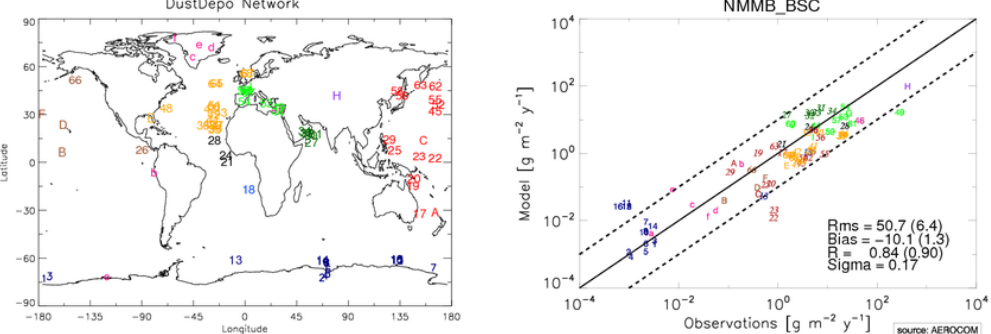
Fig. 11. Measured yearly deposition fluxes versus modeled ones in the bottom panel; units are gm − 2 yr − 1 . Location for each data point in the scatter plot is given in the left panel. Number and letters are coloured regionally for West/East Pacific (red/brown), North/Tropical/South Atlantic (orange/black/light-blue), Middle East/Asia/Europe (violet/purple/light green), Indian/Southern Ocean (dark green/dark blue) and pink ice core data in Greenland, South America and Antartica. Data from Ginoux et al. (2001)/Mahowald et al. (2009)/DIRTMAP/Mahowald et al. (1999) are indicated by letters/non-italic numbers/italic numbers/lower-case letters. Root mean square error (RMS), bias, ratio of modeled and observed standard deviation ( σ ) and correlation ( R ) are indicated for each model in the lower right part of the scatterplot. Normalized mean bias and normalized root mean square error are given in parenthesis next to RMS and mean bias, respectively. The correlation with respect to the logarithm of the model and of the observation is also given in parenthesis next to R . Black continues line is the 1:1 line whereas the black dotted lines correspond to the 10:1 and 1:10 lines.